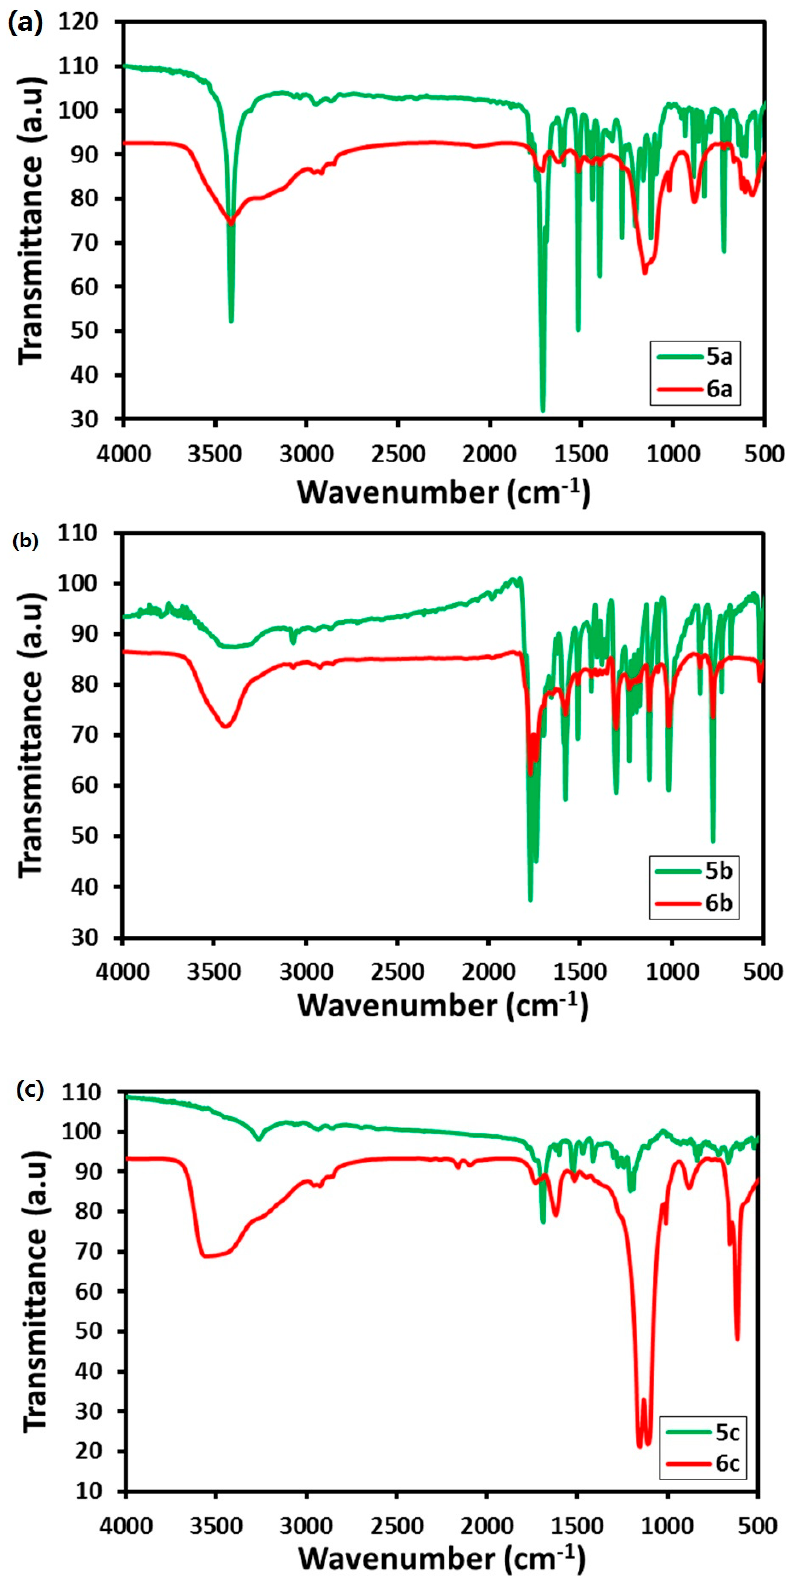
Figure 2. FT-IR spectra of 5a and 6a ( a ), 5b and 6b ( b ), 5c and 6c ( c ).